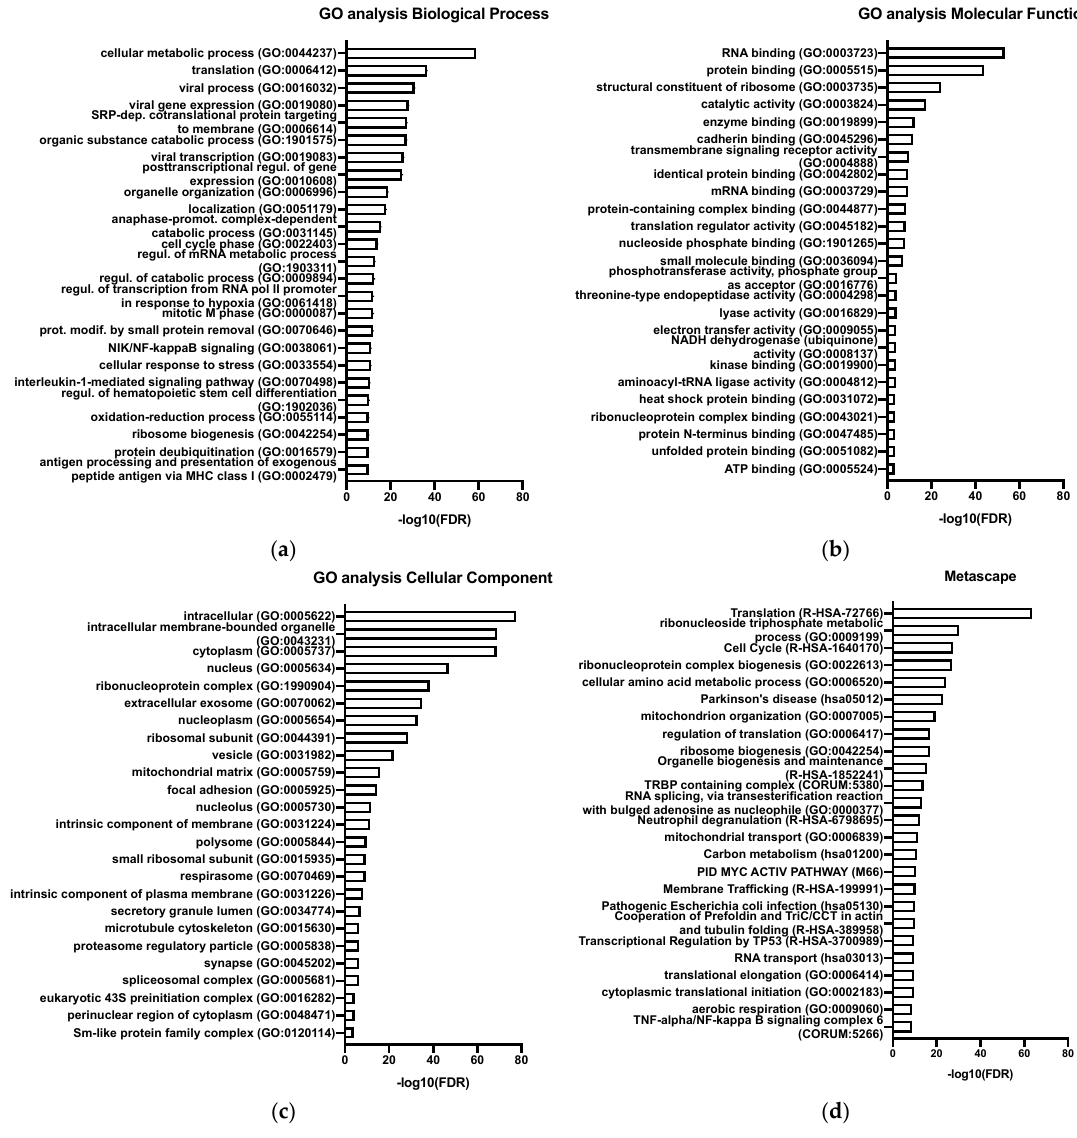
Figure 5. Gene ontology (GO) enrichment analysis in C92 EV SEC , top 25 ontology terms. ( a ) GO, biological process, ( b ) GO, molecular function, ( c ) GO, cellular component, ( d ) Metascape. Only terms with an FDR < 0.01 were selected. C92 EV SEC are enriched in genes involved in viral process, viral gene expression and